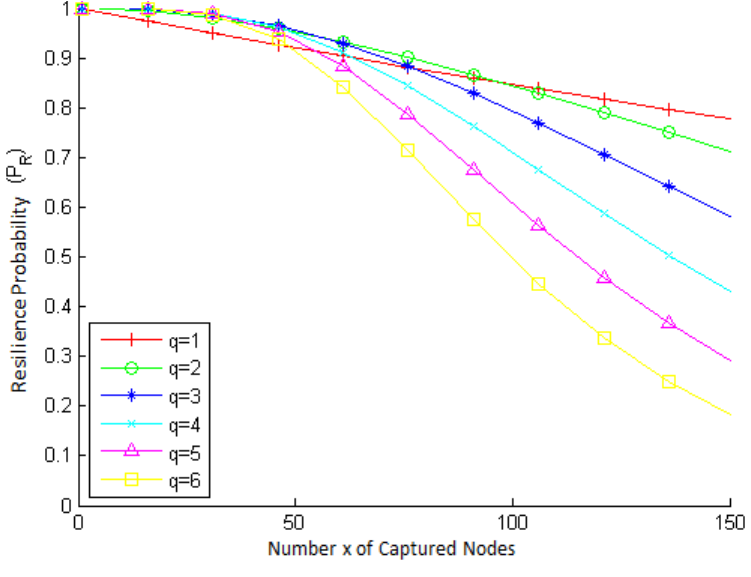
Figure 4. Key management resilience probability ( P different values of key overlap q , k = 200 keys and p = 0 . 33